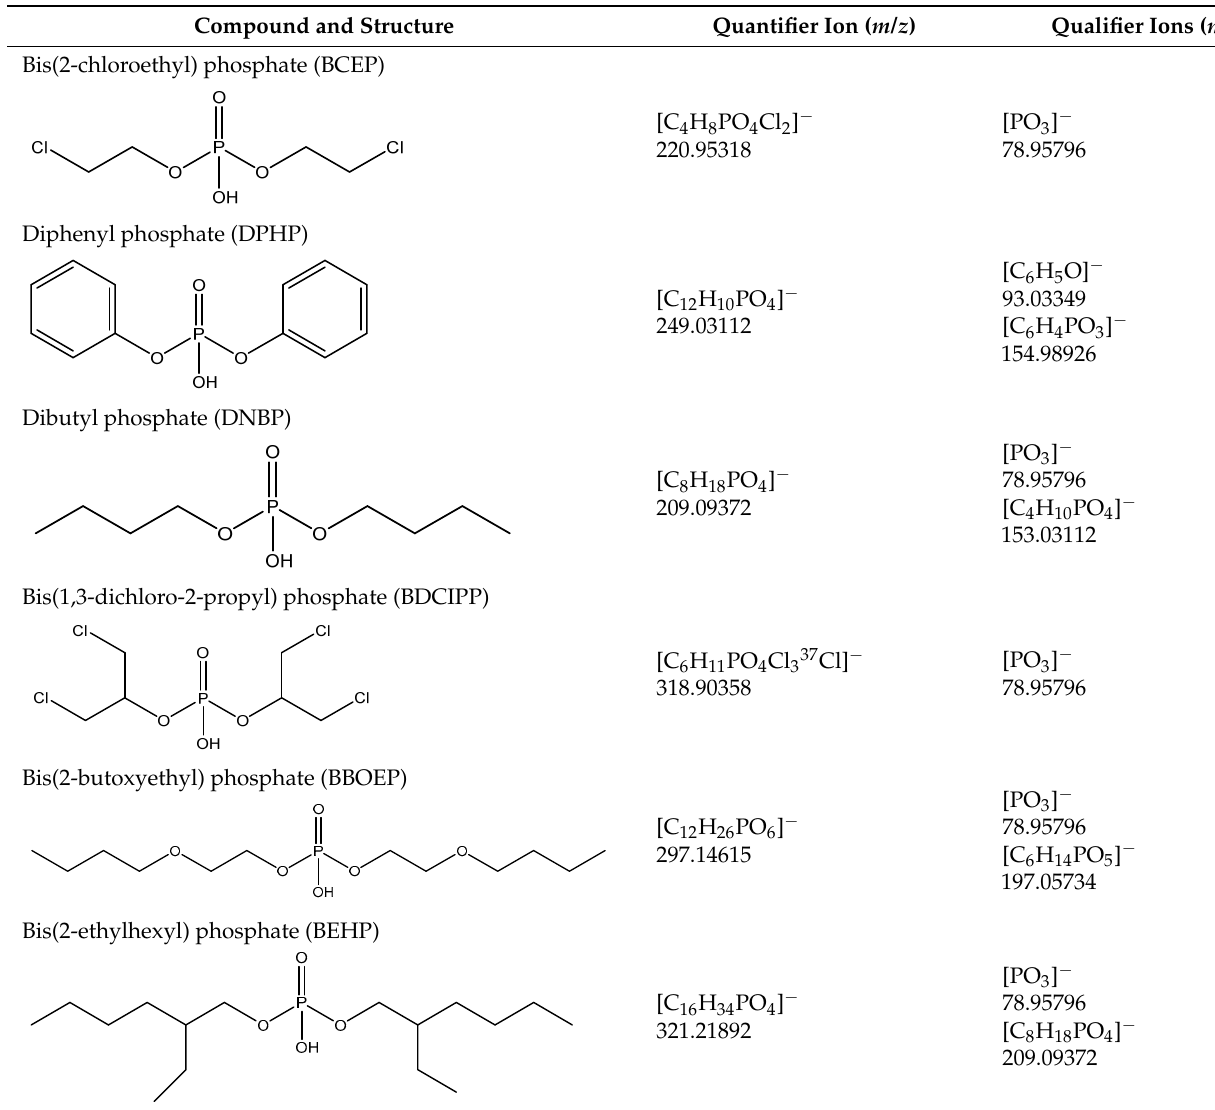
Table 1. Chemical structure of the analytes studied and exact masses of their quantifier and qualifier ions.